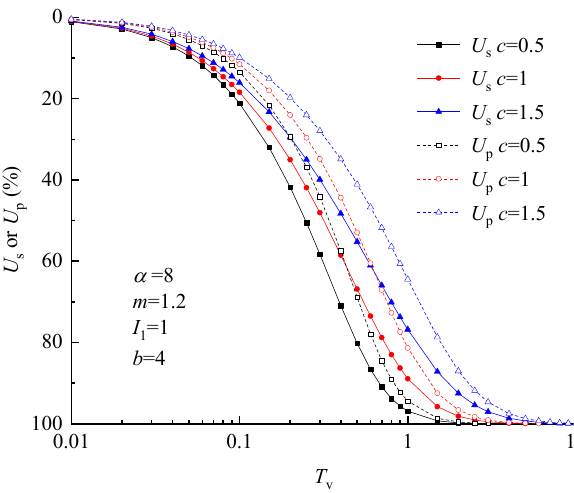
Figure 6. Influence of the c value on ACDs.